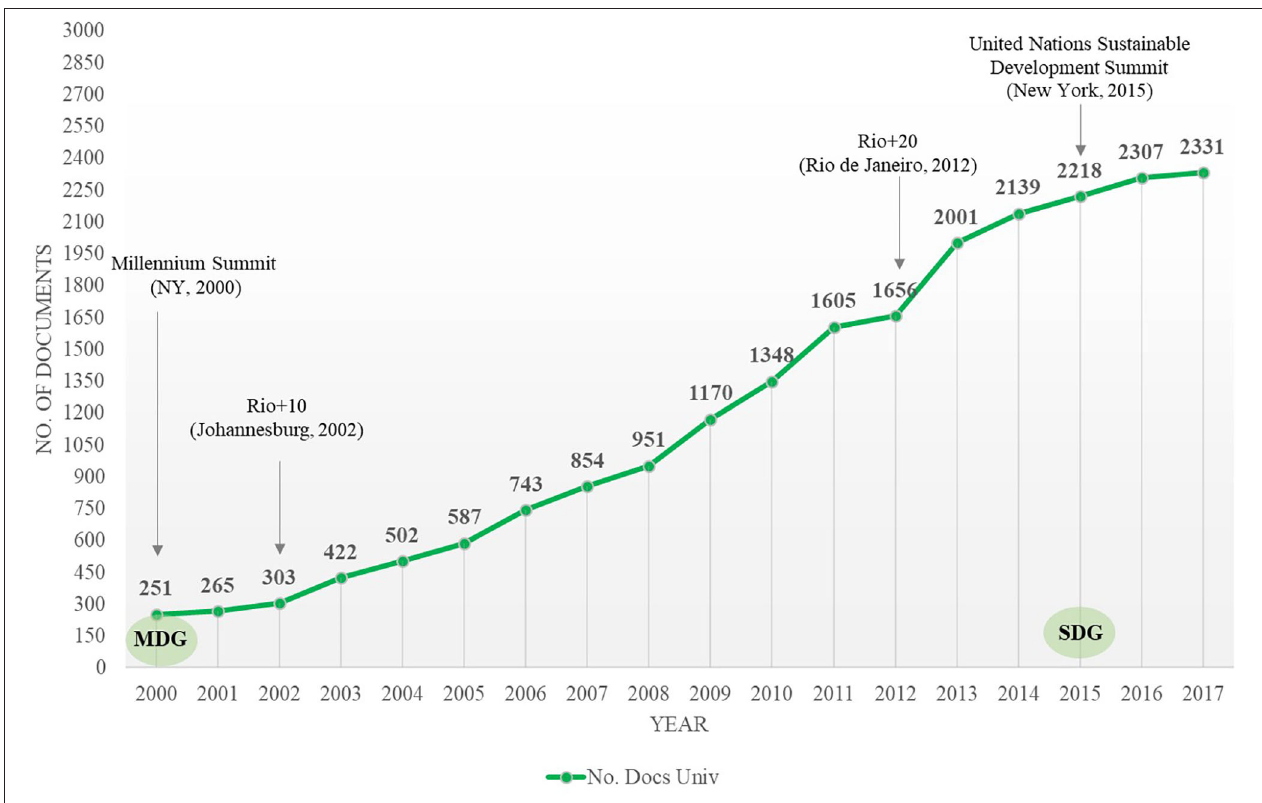
FIGURE 2 | Yearly output of the scientific production of organizations